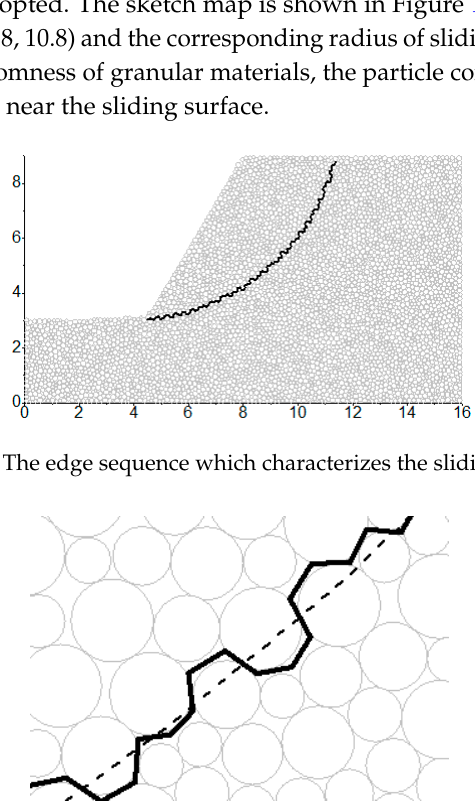
Figure 9. The granular slope example.